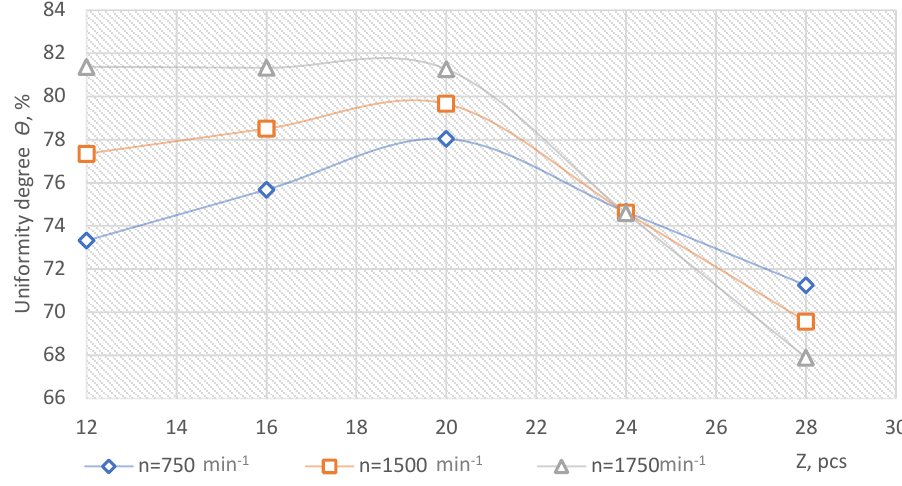
Figure 9. Dependence of the degree of homogeneity Θ ,% on the number of stationary blades Z, pcs, at different speeds at angles β 2 = 30 ◦ and β st = 30 ◦ .